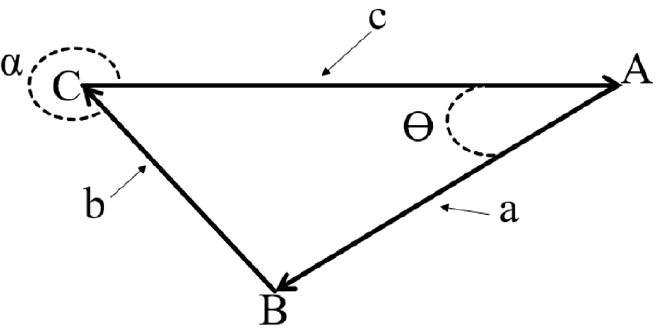
Figure 7. Vectorial representation of the mechanism.